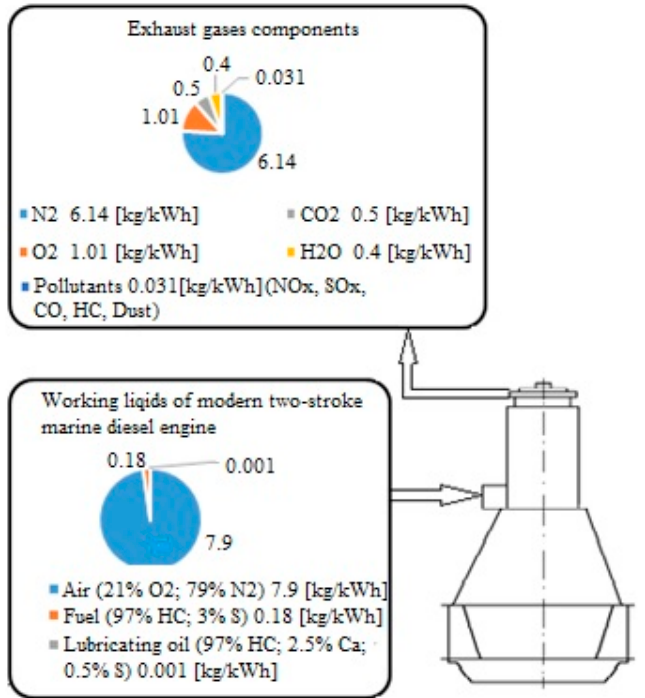
Figure 2. Exhaust gas components of a modern two-stroke marine diesel engine (based on [4]).